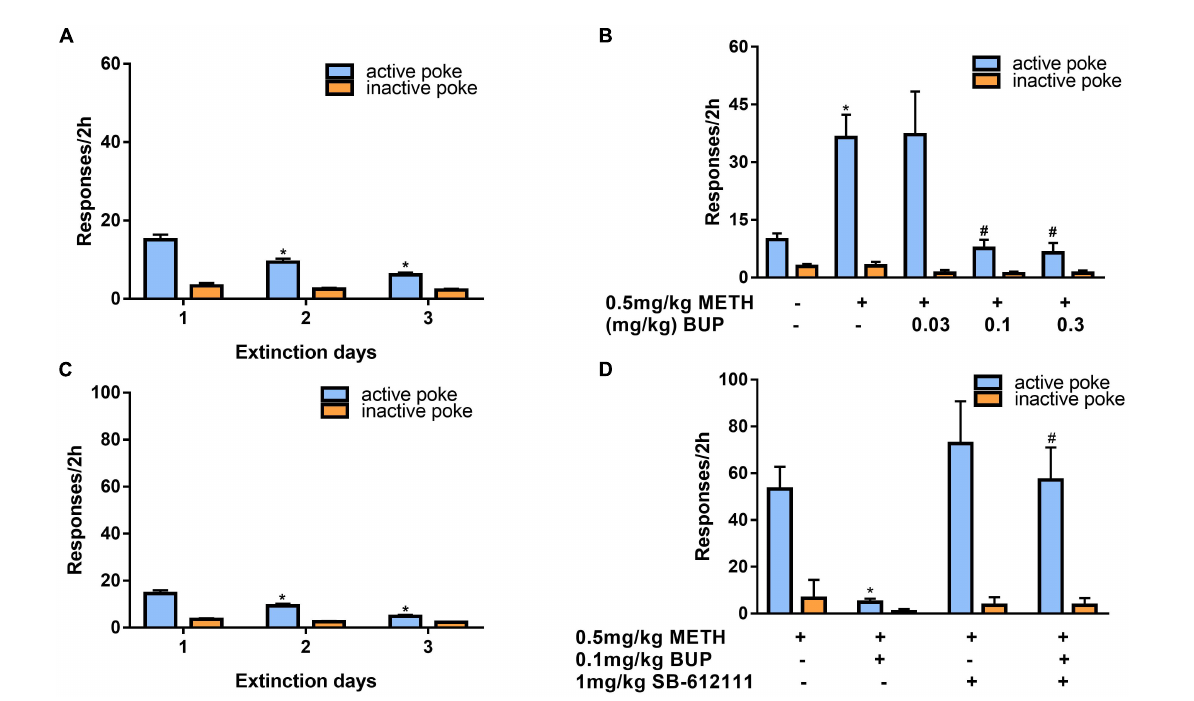
FIGURE5 Effects of buprenorphine or SB-612111 combined with buprenorphine on drug-seeking induced by METH priming in rats. (A) The rats were extinguished for 3 days. * P < 0.05 vs. first day extinction. (B) Effects of buprenorphine on drug-seeking behavior induced by METH priming. The active responses increased significantly after administration of METH and buprenorphine inhibited the active responses in a dose-dependent manner. * P < 0.05 vs. vehicle, # P < 0.05 vs. buprenorphine alone. (C) The rats were extinguished for 3 days. * P < 0.05 vs. first day extinction. (D) Effects of SB-612111 combined with buprenorphine on drug-seeking behavior induced by METH priming. SB-612111 pretreatment reversed the inhibitory action of buprenorphine on active responses induced by METH priming, but it alone failed to affect the active responses. Data shown are means ± S.E.M. * P < 0.05 vs. METH priming, #P < 0.05 vs. buprenorphine treatment.